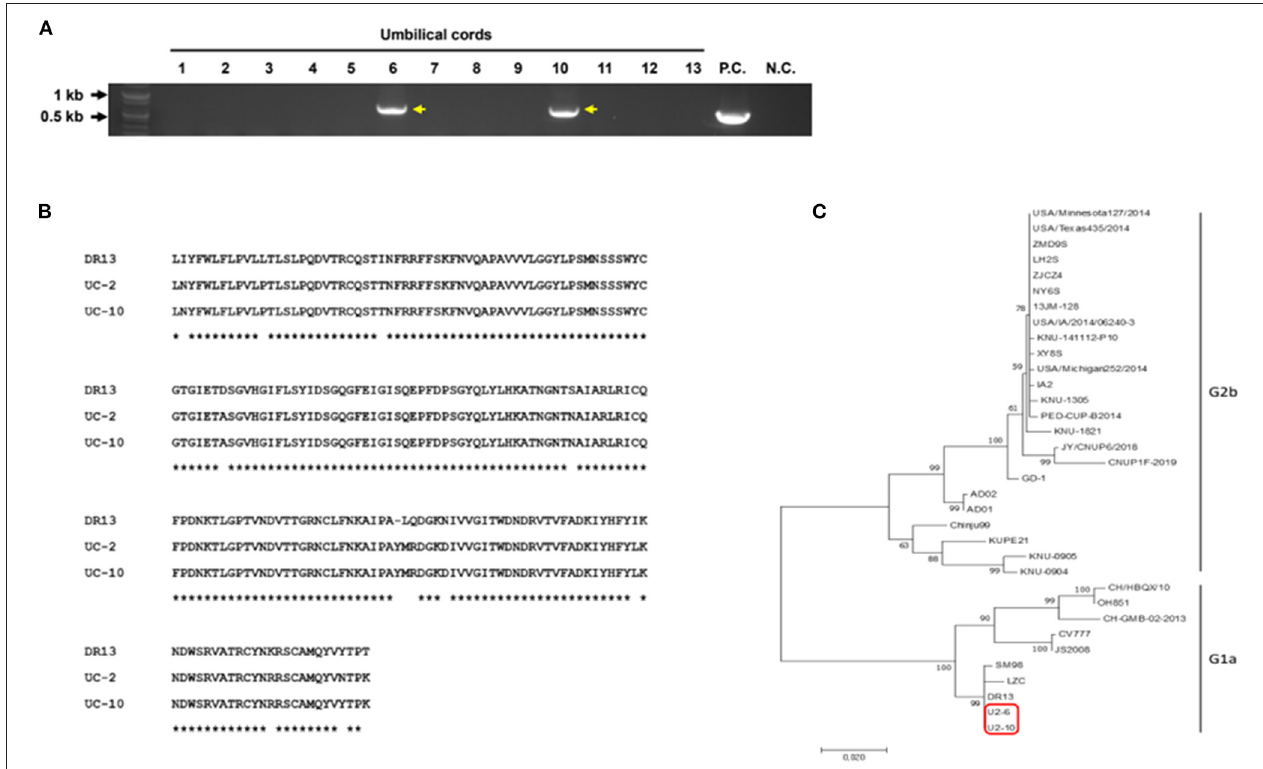
FIGURE 2 | Detection and characterization of PEDV from umbilical cord tissues. (A) RT-PCR results on 13 umbilical cords targeting PEDV M gene (P.C., positive control; N.C., negative control). (B) Amino acid alignment of the partial PEDV spike protein. Partial PEDV spike was sequenced. * indicates identical sequences. (C) Phylogenetic tree of partial PEDV spike genes from published PEDV strains from GenBank and PEDVs from umbilical cords (red